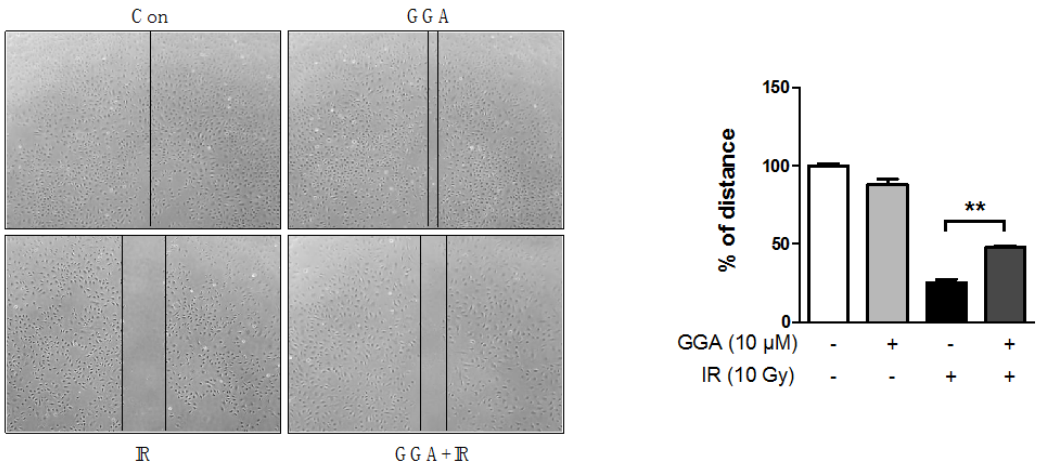
5 of 11 Figure 5. Protective effects of GGA on tube formation activity following IR. Images showing